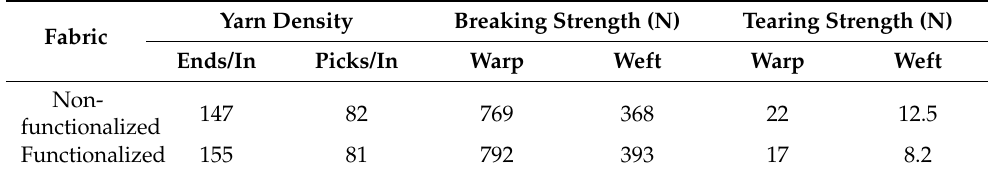
Table 2. Physical properties of PES/CO fabric. Yarn Density Breaking Strength (N) Tearing Strength (N) Fabric Ends/In Picks/In Warp Weft Warp Weft Non- 147 82 functionalized